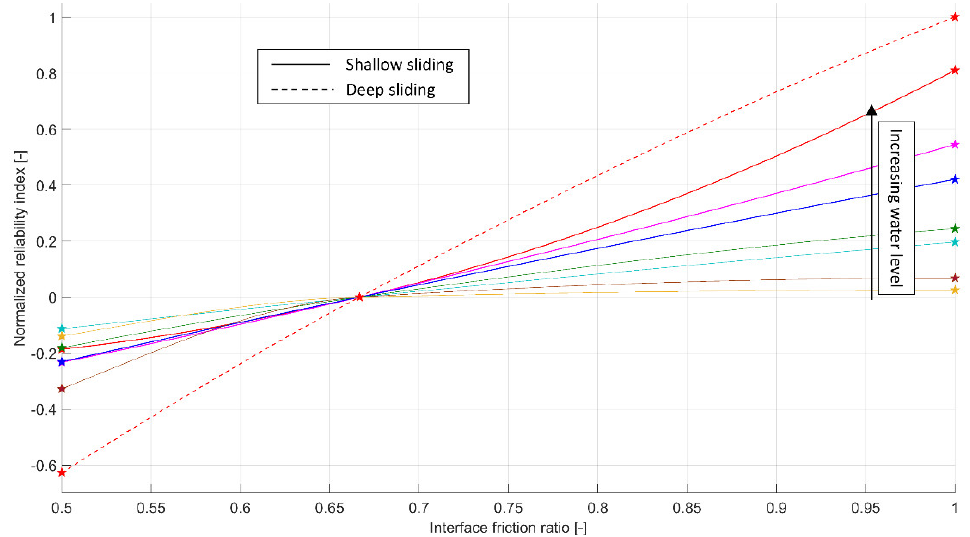
Figure 11. Trend of reliability index increase with increase of interface friction ratio for